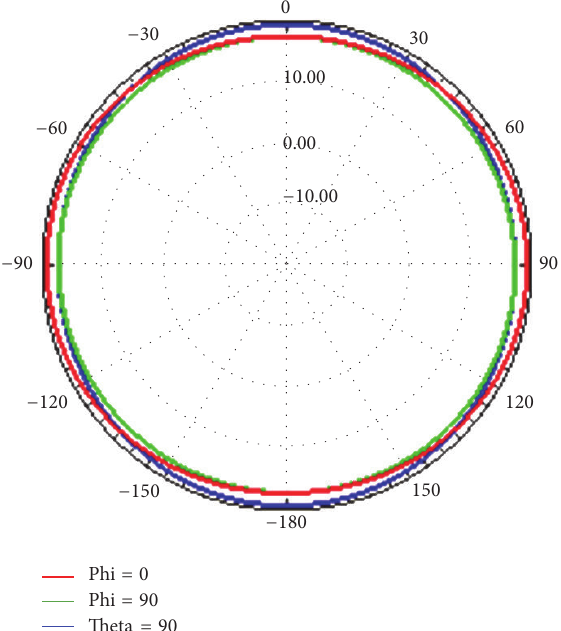
Figure 10: Radiation pattern ( 𝐸 total ) in 2D of the 3D spherical antenna (Table 4) in the planes: 𝑥𝑧 , 𝑦𝑧 , and 𝑥𝑦 .